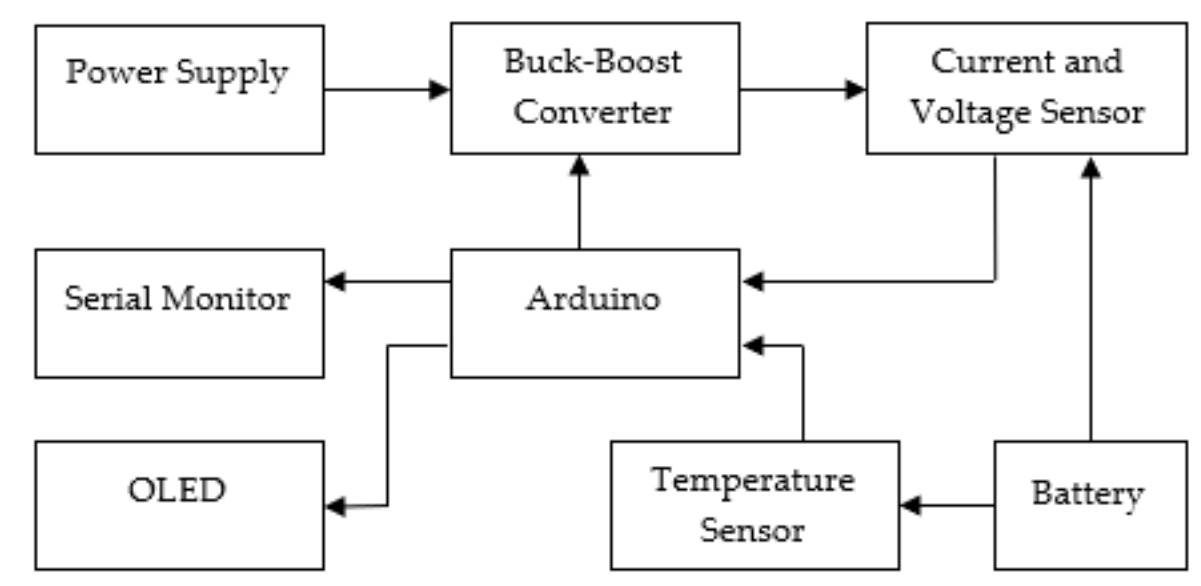
Figure 3. Block diagram of the proposed system.